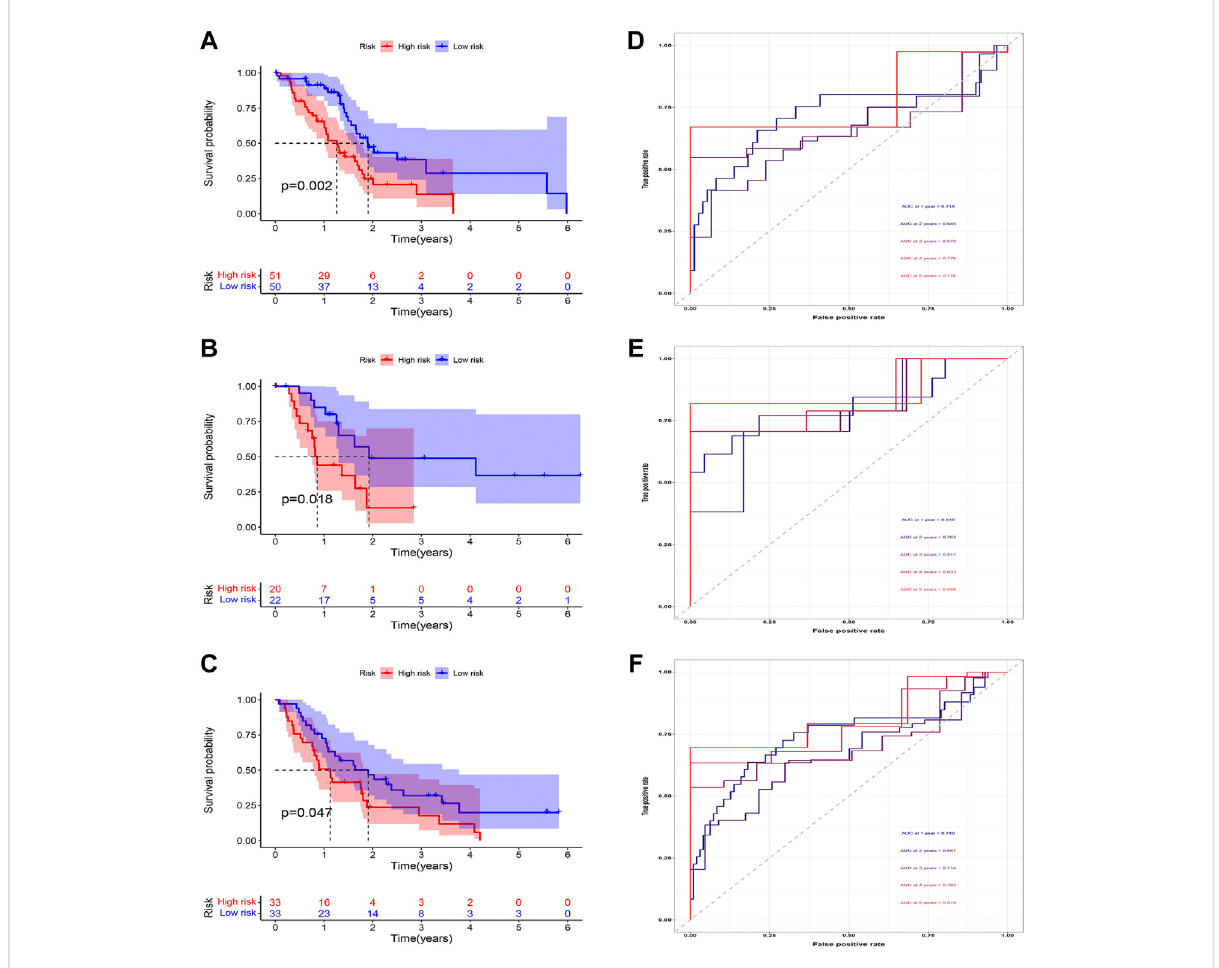
FIGURE 8 Evaluationofthecombinedprognosticmodel. (A – C) Intraining,test,andvalidationcohorts,Thehigh-riskpatientshadaworseprognosis (D – F) The AUC in t training, test, and validation cohorts was basically between 0.7 and